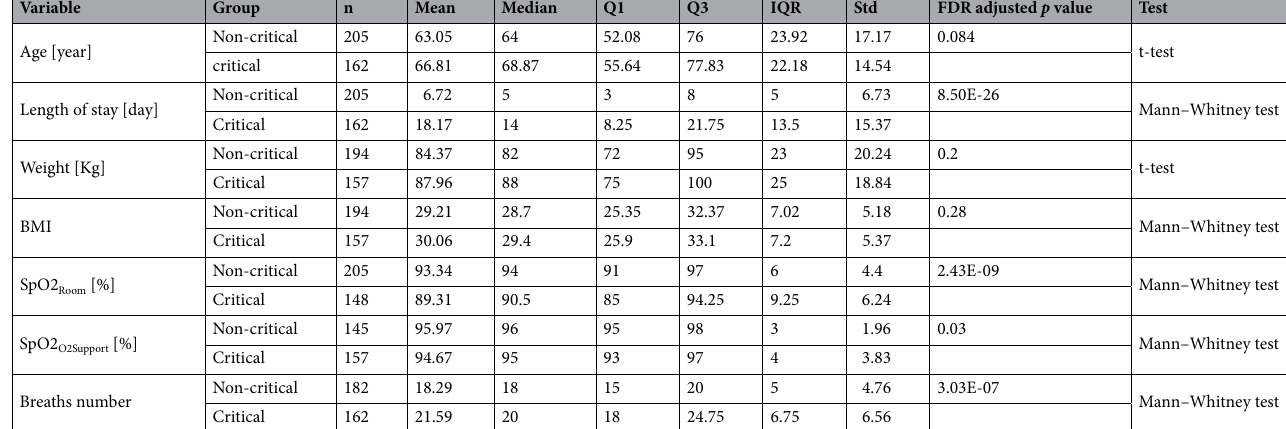
Table 2. Critical and non-critical patient characteristics: demographic, length of stay, and respiratory parameters at